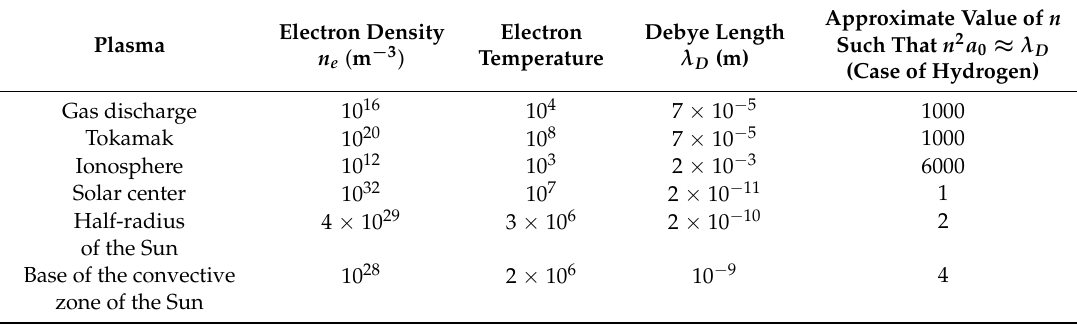
Table 1. Debye length and approximate value of n such that n 2 a 0 = λ D (case of hydrogen).